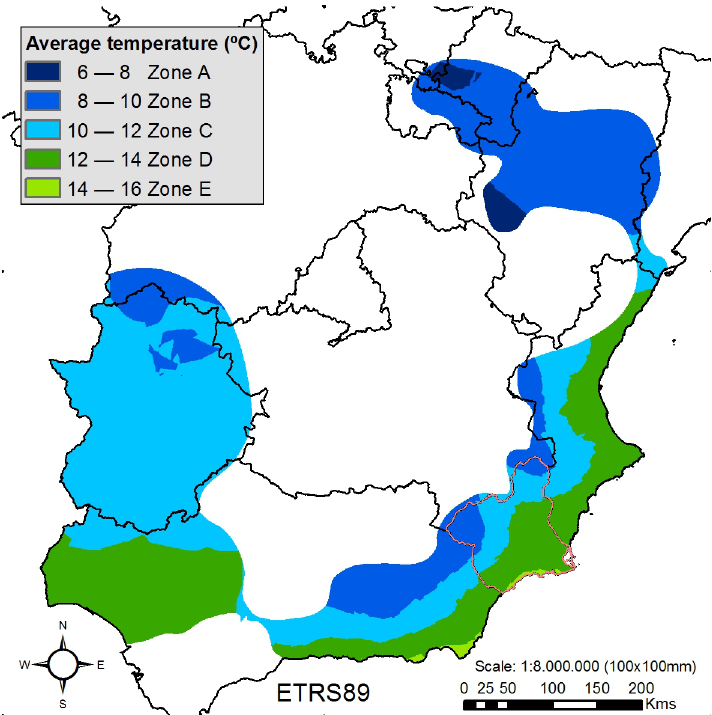
Figure 6. Climatic classification of stone fruit tree growing areas in Spain.